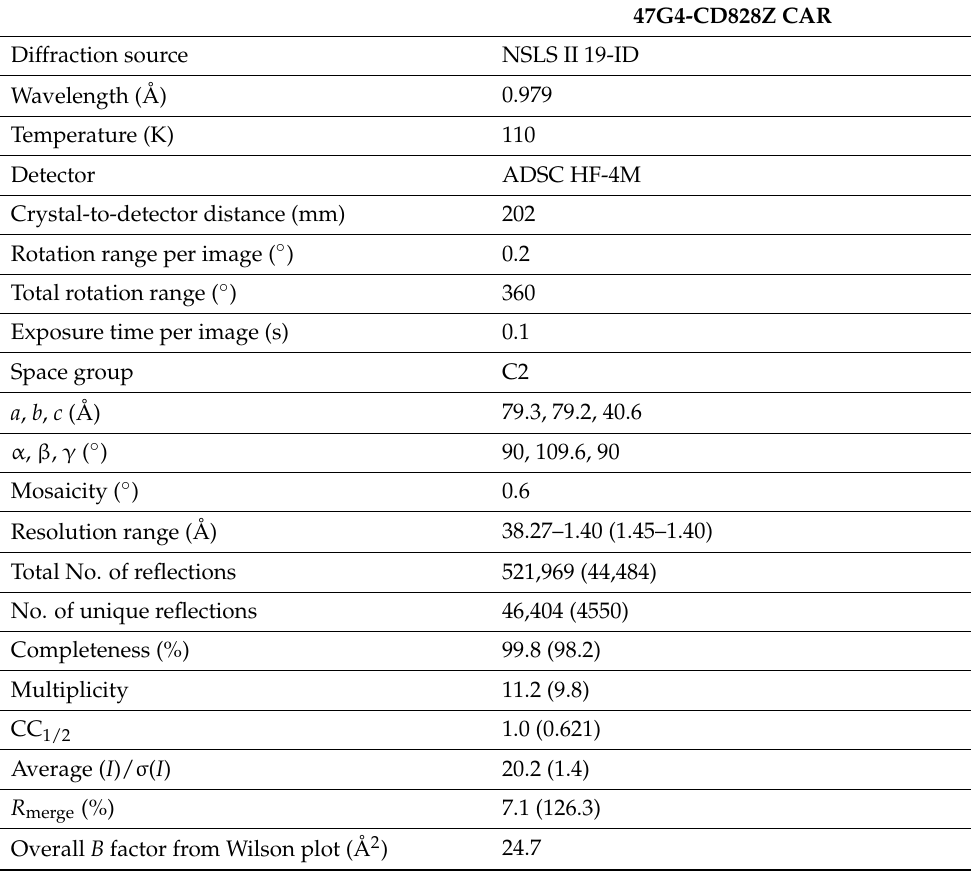
Table 2. Data collection and processing. Values in parentheses are for outer